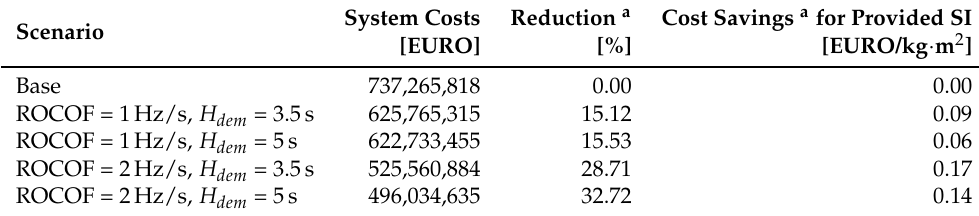
Table 5. Overall system costs and cost savings with respect to the provided SI of the analysed